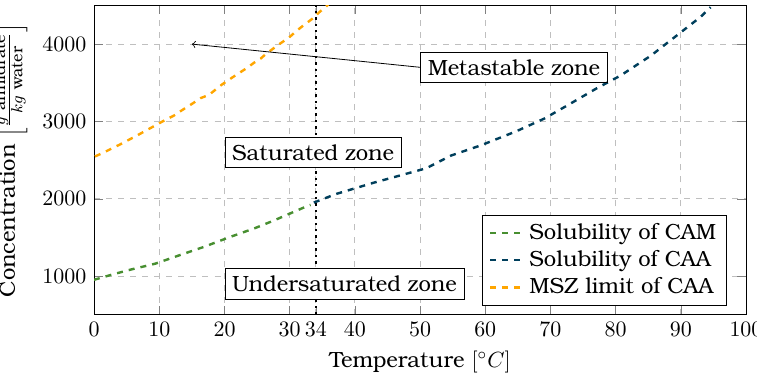
Figure 1. Solubility and supersaturation diagram of CAM and CAA based on